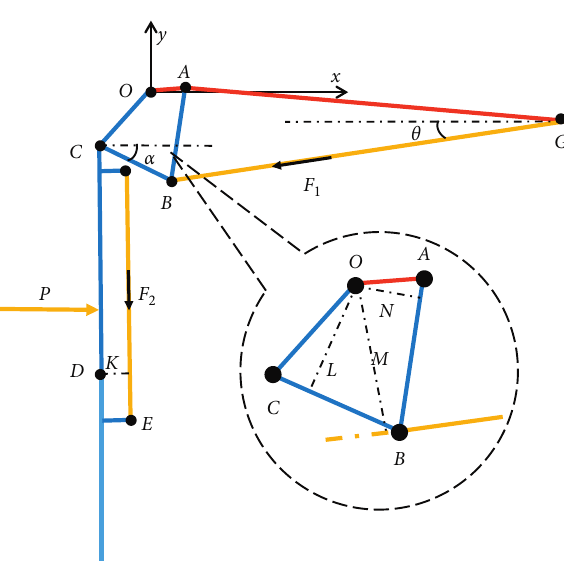
Figure 7: Stress analysis diagram of the integral face